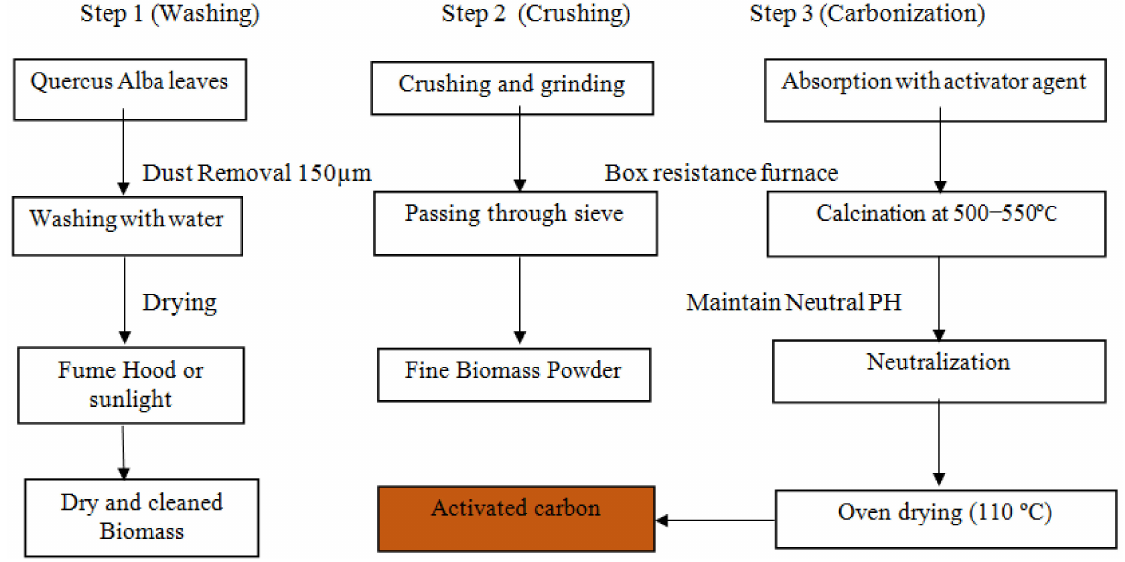
Figure 2. Preparation steps of activated